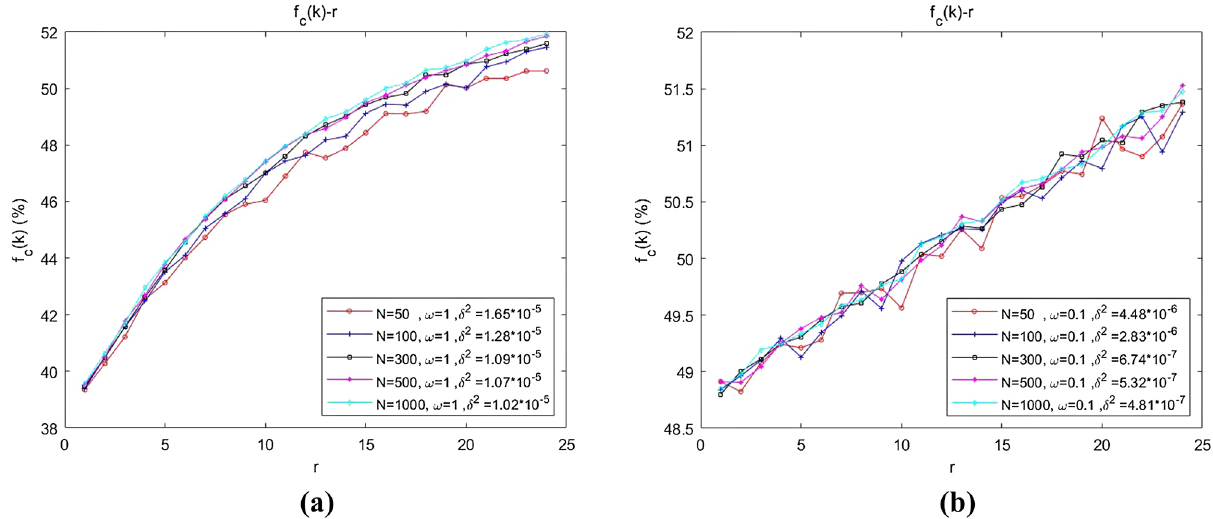
Figure 6. ( a ) Dependence of the emergence of collaboration on swarm size with strong selection; ( b ) dependence of the emergence of collaboration on swarm size with weak